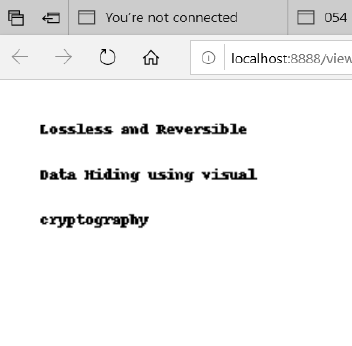
Table 1. Comparison of images with di ff erent parameters